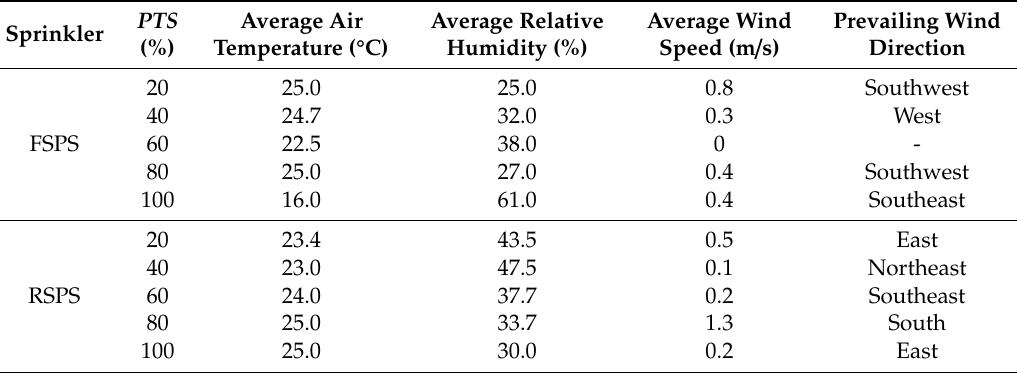
Figure 4. Layout of the collectors during the performance evaluation of the center pivot irrigation system: ( a ) collector size and setting height on Line 1; ( b ) photograph of the experimental setup. Table 2. Main environmental parameters of the field tests.